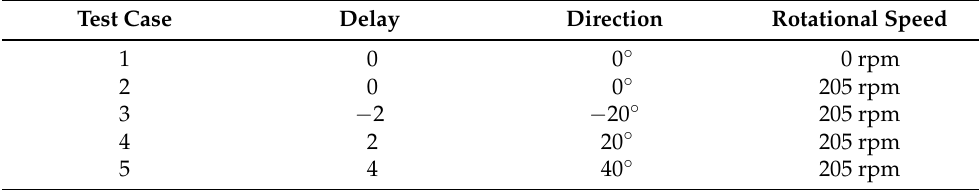
Table 2. Test cases of the rotating speaker beam configuration in the microphone array